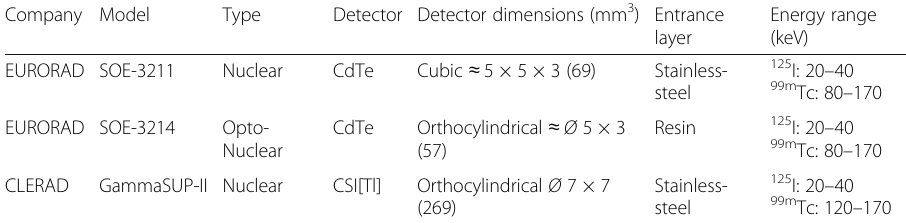
Table 1 Probes ’ features Company